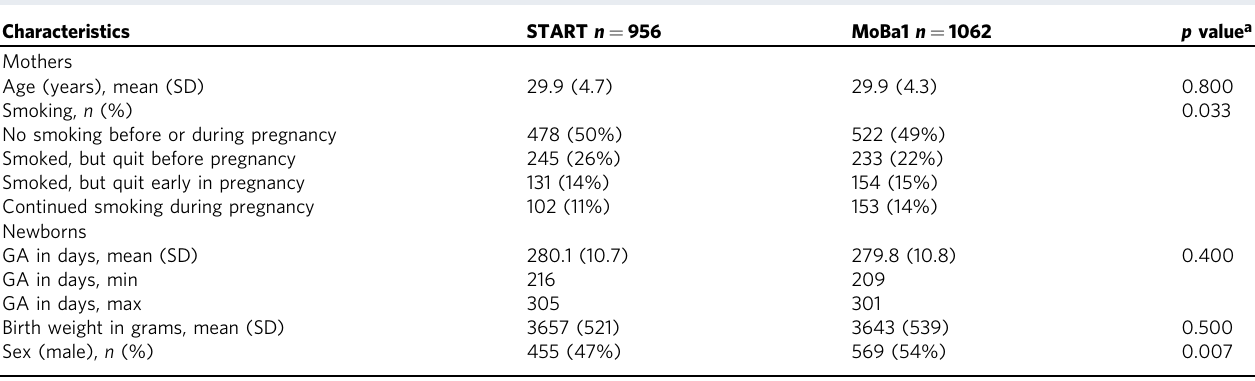
Table 1 Characteristics of the mothers and newborns in START and MoBa1.